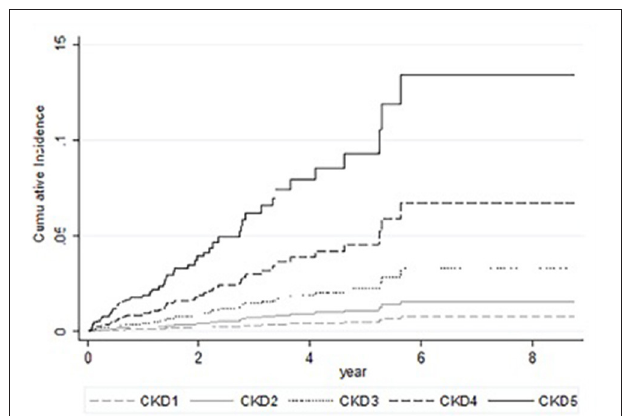
FIGURE 2 | Cumulative incidence of tuberculosis in competing-risks analysis of patients with chronic kidney disease with adjustments for patients’ age, gender, body mass index, diabetes, liver cirrhosis, serum calcium, and serum